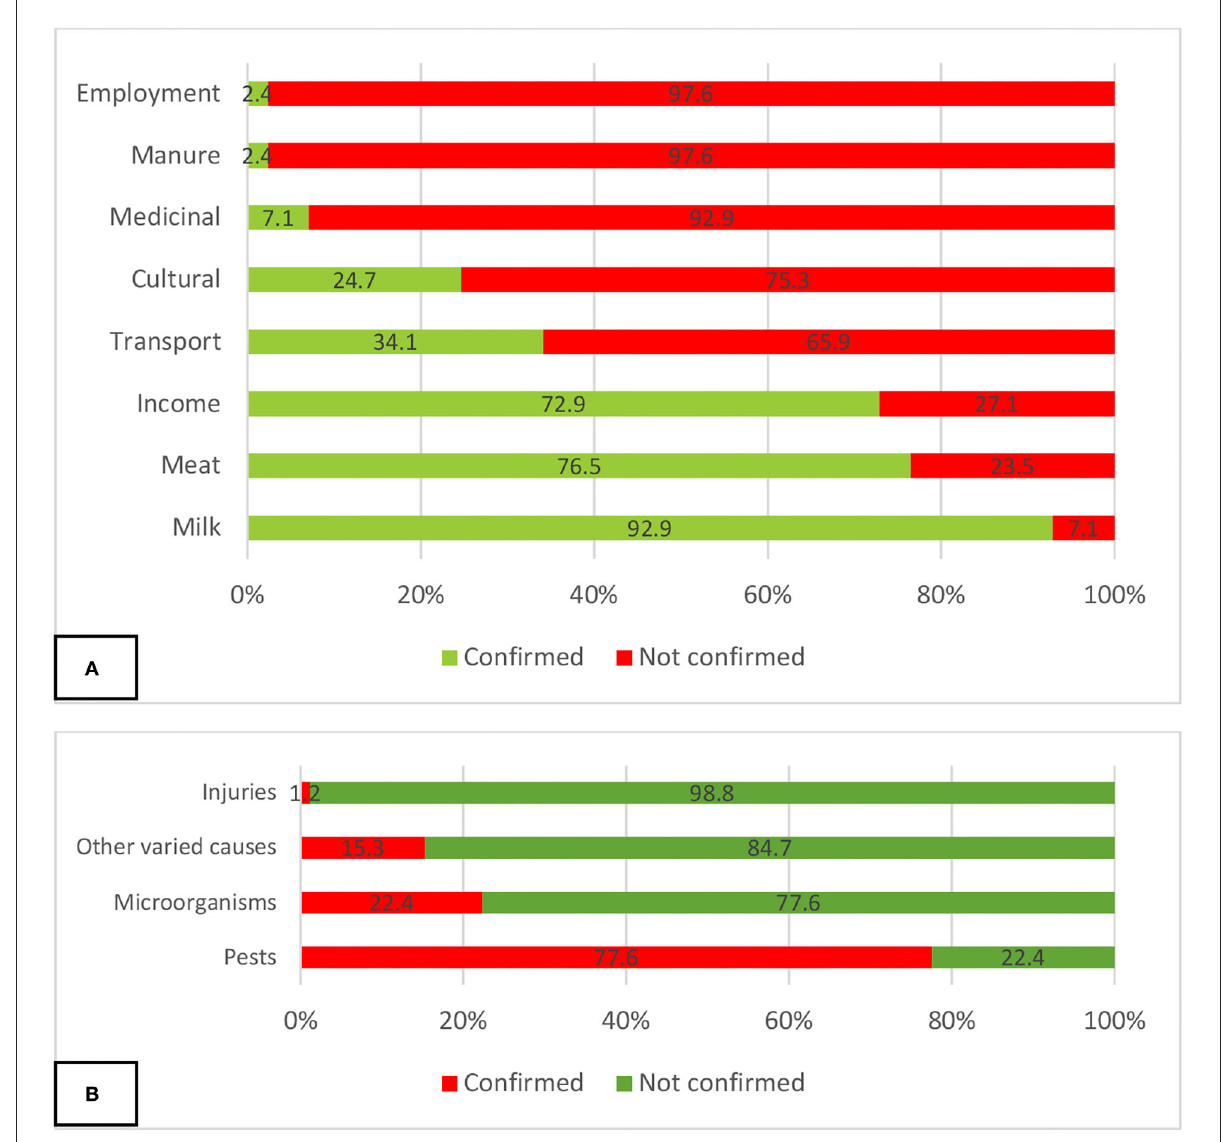
FIGURE2 Self-reported (A) benefits of camel rearing and (B) leading causes of camel diseases.